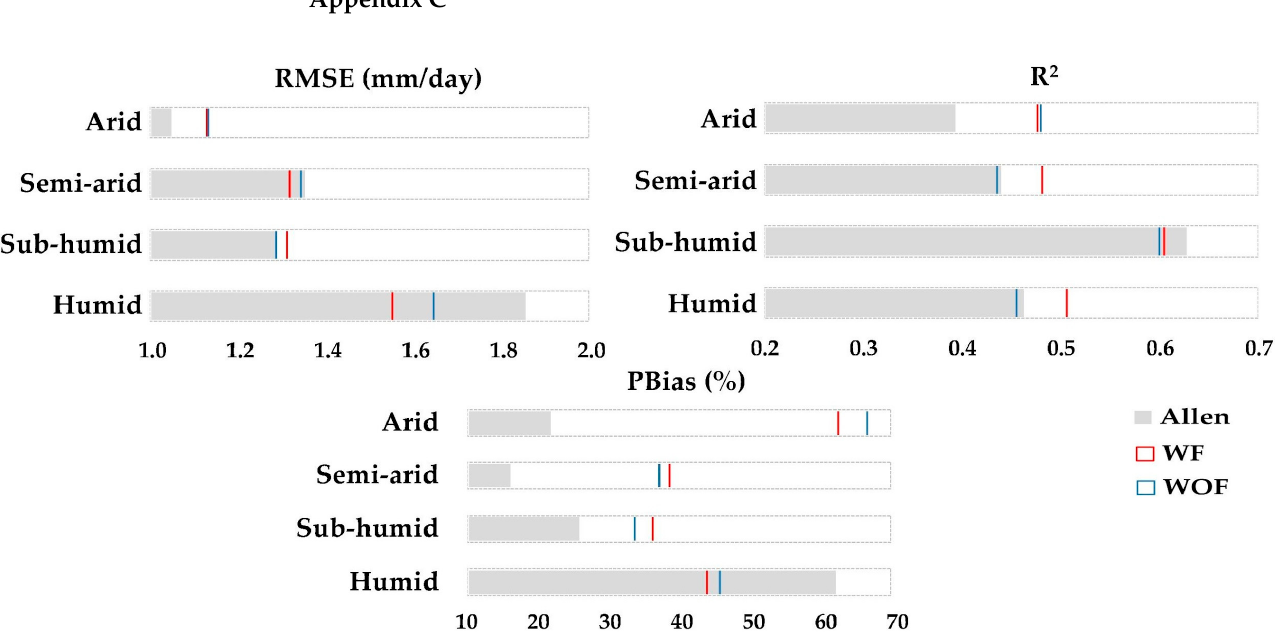
Figure A3. Evaluation of endmember selection procedures based on aridity index climate types.